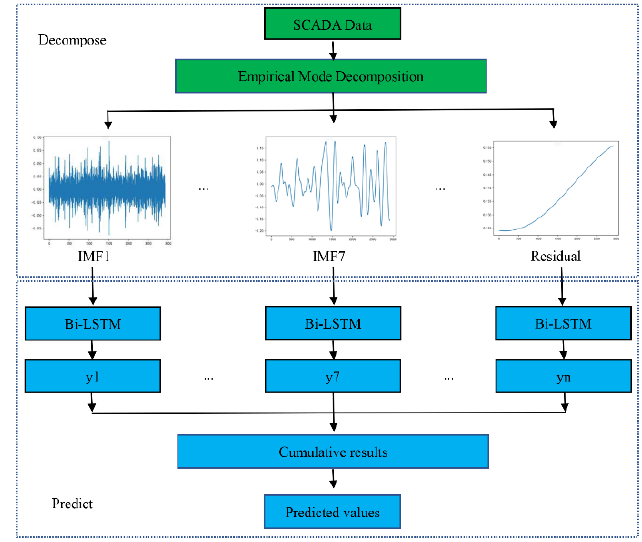
Figure 2. EEMD − BiLSTM model prediction flow chart.